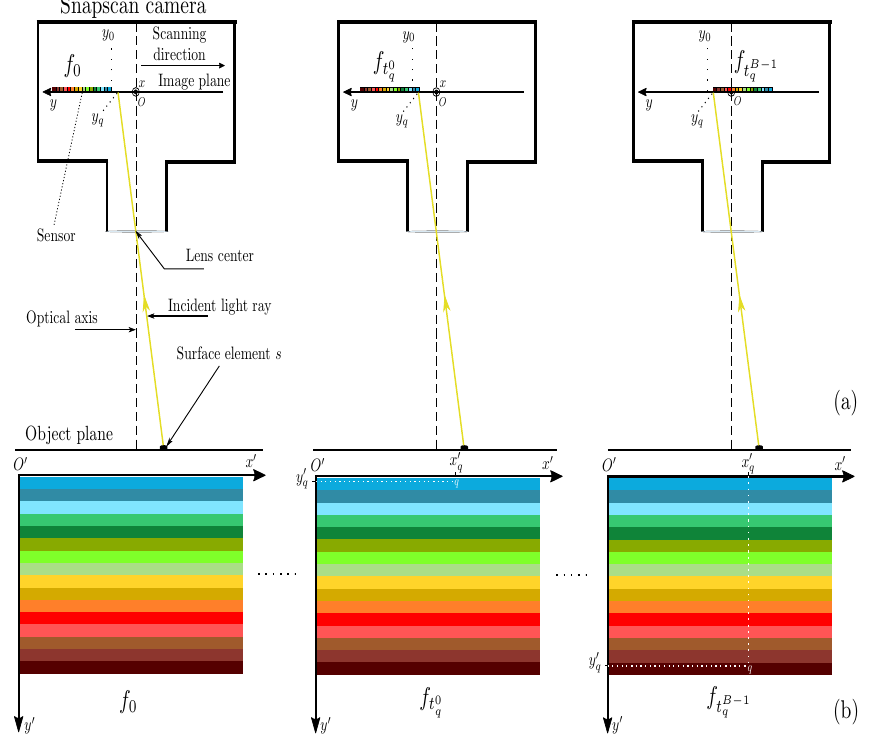
Figure 1. ( a ) Side view of Snapscan camera observing a surface element s of a static scene. ( b ) The loca- tion of the measured radiance observed at point q associated to s in frames acquired at t = 0, t 0 q , t B − 1 q